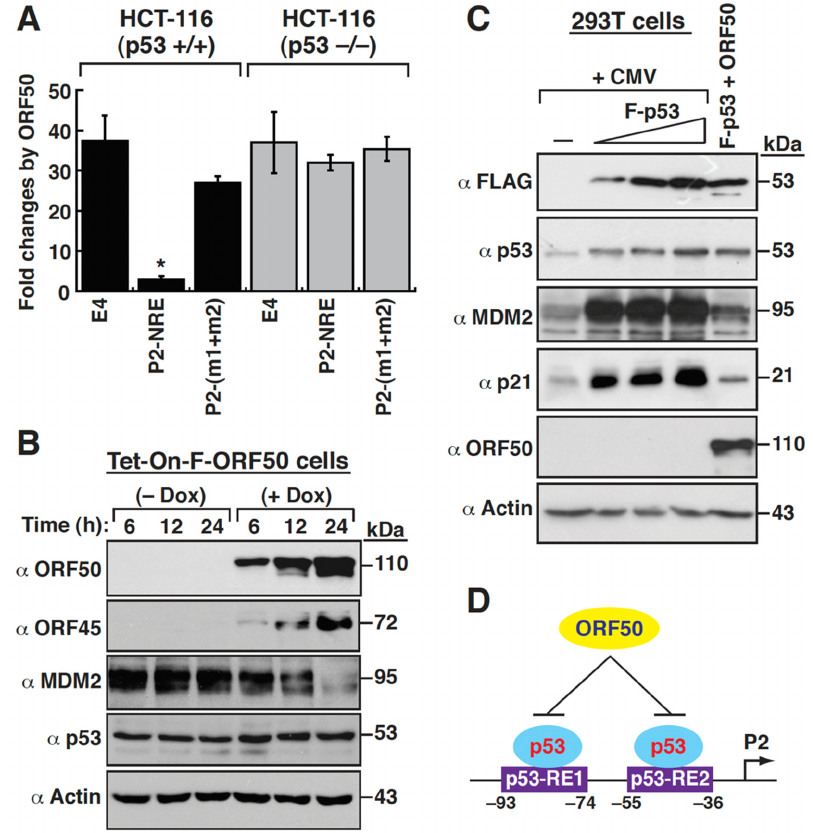
Figure 8. Inhibition of p53-mediated transactivation by ORF50. ( A ) Responsiveness of different reporter constructs including pE4-luc, P2-NRE/E4, and P2(m1+m2)/E4 to ORF50 in p53-wild-type and p53-null HCT116 cells. After cotransfection with the indicated reporter constructs and the ORF50- expressing vector or the empty vector control in HCT116 (p53+/+) cells or in HCT116 (p53 − / − ) cells for 30 h, cells were harvested for luciferase reporter assays. Fold change was calculated as the luciferase activity of the indicated reporter construct in the presence of the ORF50 expression plasmid divided by that in the presence of the empty vector control (CMV). *, p < 0.05, for results compared to those with pE4-luc. ( B ) Western blot analysis of the expression levels of MDM2 and p53 in HH-B2(Tet-On-F-ORF50) cells after ORF50 overexpression. HH-B2(Tet-On-F-ORF50) cells that were left untreated or treated with doxycycline for 6, 12, and 24 h were examined for the expression of MDM2, p53, ORF50, and ORF45 by immunoblotting. ( C ) Effect of ORF50 on p53-mediated MDM2 upregulation in 293T cells. Cells were cotransfected with the plasmid expressing FLAG-tagged p53 (F-p53) and the empty control vector or the ORF50 expression plasmid for 30 h, and the expression levels of p53, MDM2, p21, and ORF50 in these transfected cells were examined by Western blot analysis. ( D ) Proposed model for the repression of p53-mediated MDM2 upregulation by